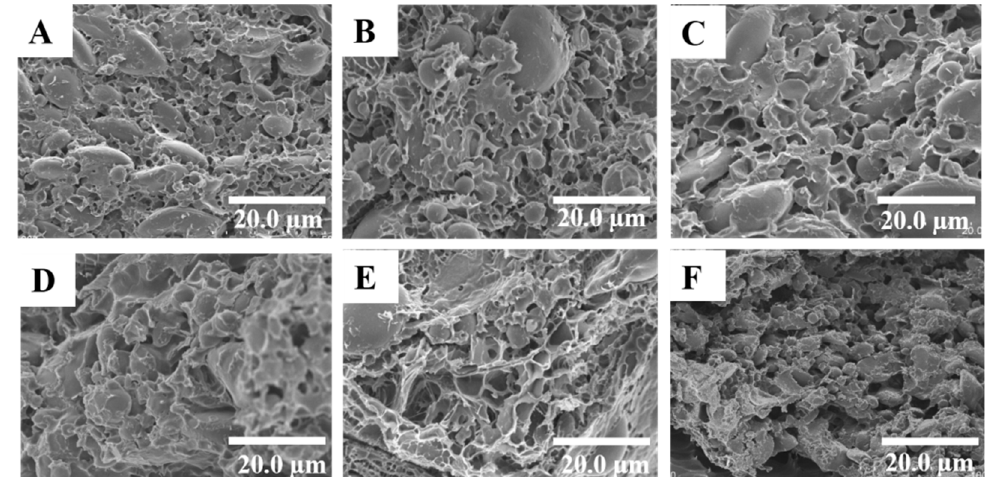
Figure 5. Scanning electron micrographs of frozen dough with different proportions of KGM added during frozen storage. Fresh dough sample with 2.5% KGM ( A ), frozen for 60 days with 2.5% KGM ( B ), frozen for 60 days with 2.0% KGM ( C ), frozen for 60 days with 1.5% KGM ( D ), frozen for 60 days with 1.0% KGM ( E ), and frozen for 60 days with 0.5% KGM ( F ).